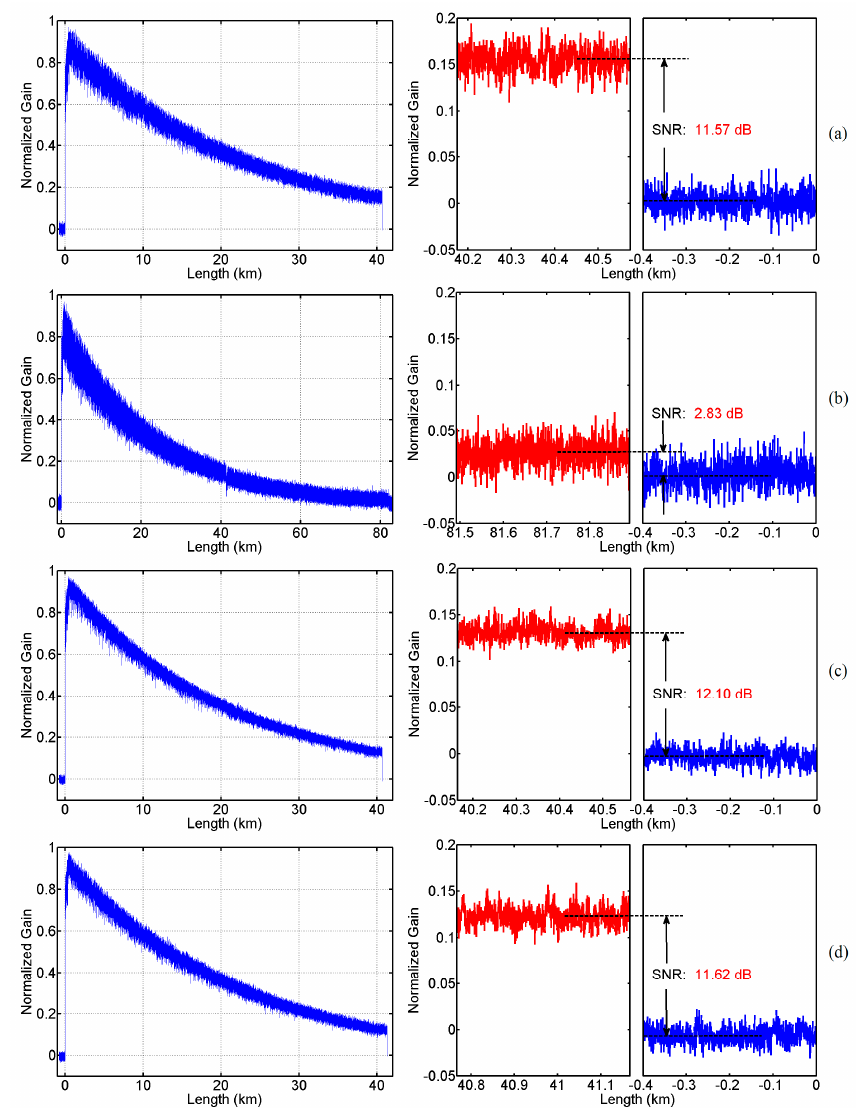
Figure 6. Normalized Brillouin time domain trace of ( a ) the 40.6 km SMF measured with the unidirectional BOTDA system (left); ( b ) the 81.9 km SMF measured with the unidirectional BOTDA system (left); ( c ) the λ 1 channel measured with the BD-BOTDA system (left); and ( d ) the λ 2 channel measured with the BD-BOTDA system (left). Each trace is measured at Brillouin center frequency shift of the SMF. Insets: the contrast between the Brillouin signal near the end of the fibers (red curve) and the noise background (blue curve) on the right hand side.